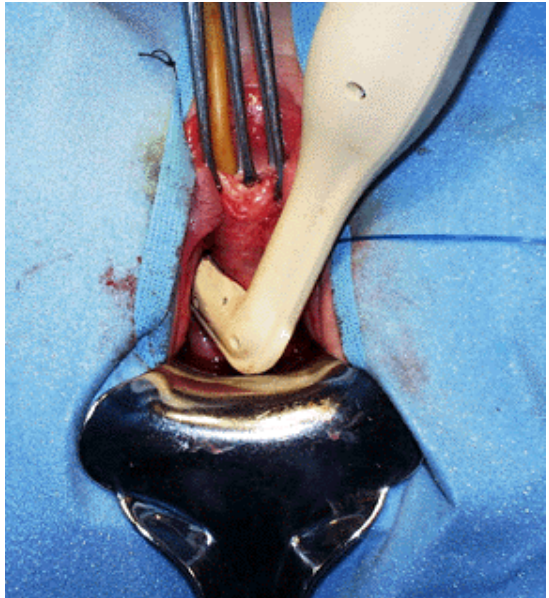
FIGURE 2. The bone drill is used to deliver a bone anchor into the inferior aspect of the pubic bone without requiring a vaginal incision. The urethra should be well clear of the drill and the anchor should be secured at the level of the bladder